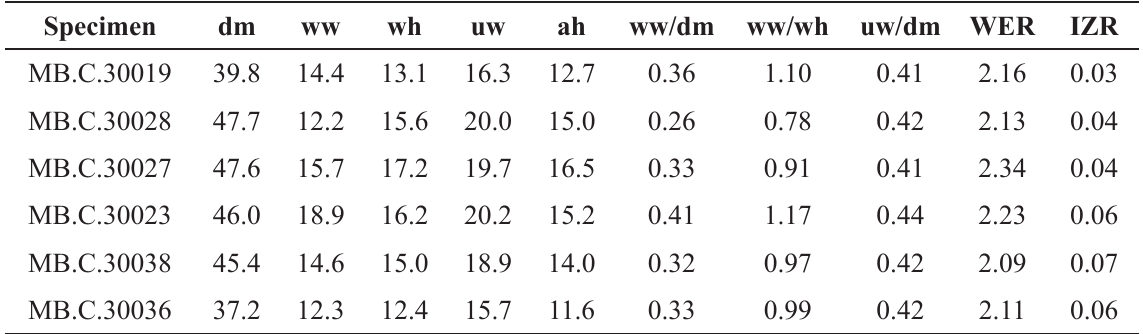
Table 30. Conch dimensions (partly estimated) and ratios of the holotype of Abichites abichi Shevyrev, 1965 from Baghuk